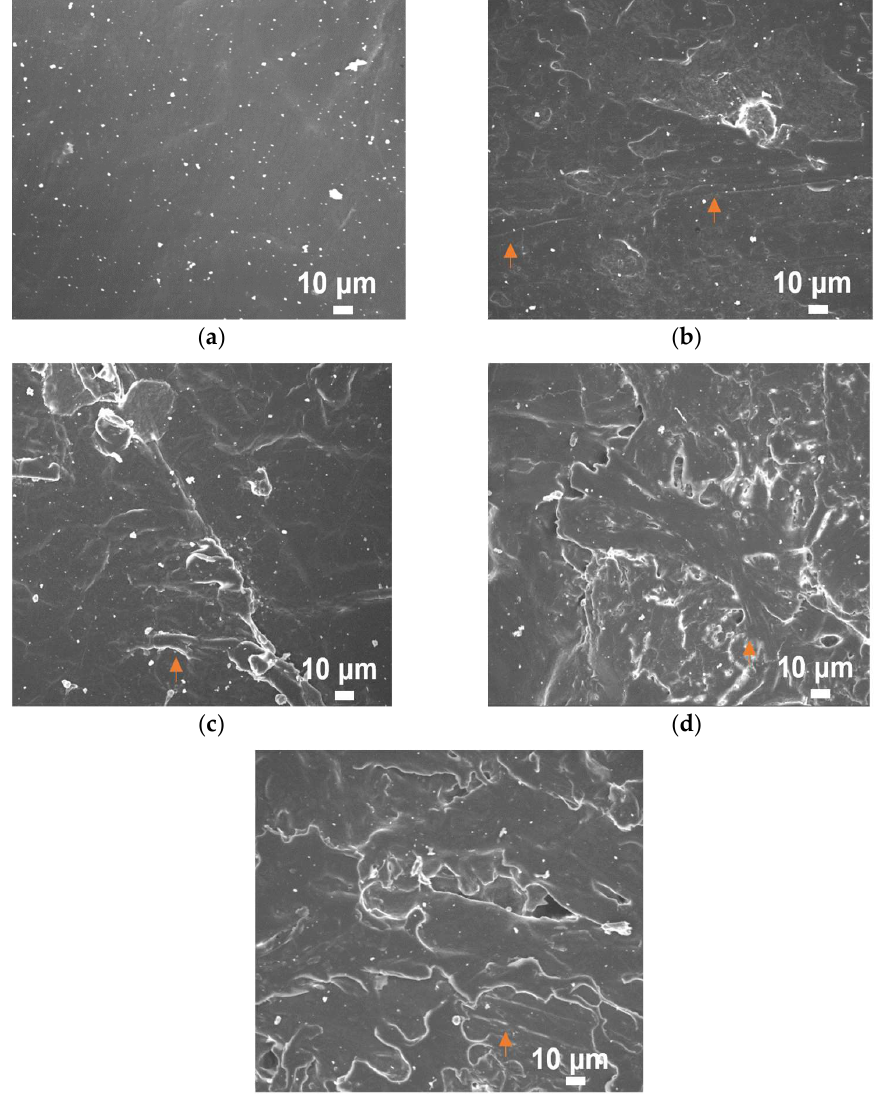
Figure 11. Microphotographs of ( a ) r-HDPE and r-HDPE + ( b ) 10% wt., ( c ) 20% wt., ( d ) 50% wt., and ( e ) 75% wt. HF + PE-g-MA composite materials. Magnification ×500.